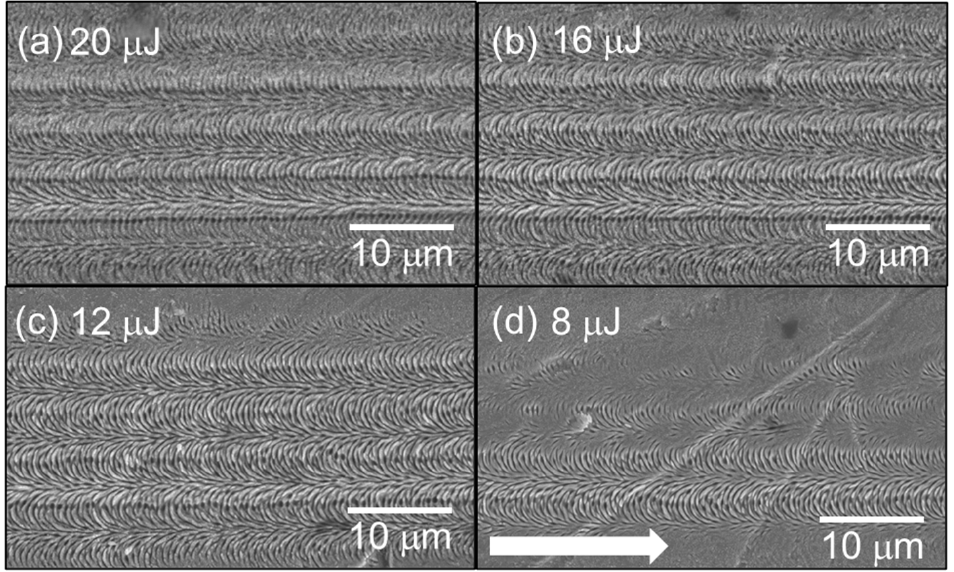
Figure 6. Nanostructures on the tungsten surface produced by non-cylindrical femtosecond vector beams with different average powers. The target scanning speed was kept at 0.06 mm/s. The single-ended arrow indicates the target scanning direction. The single pulse energies irradiated on the target surface were respectively 20 µ J ( a ), 16 µ J ( b ), 12 µ J ( c ) and 8 µ J ( d ).